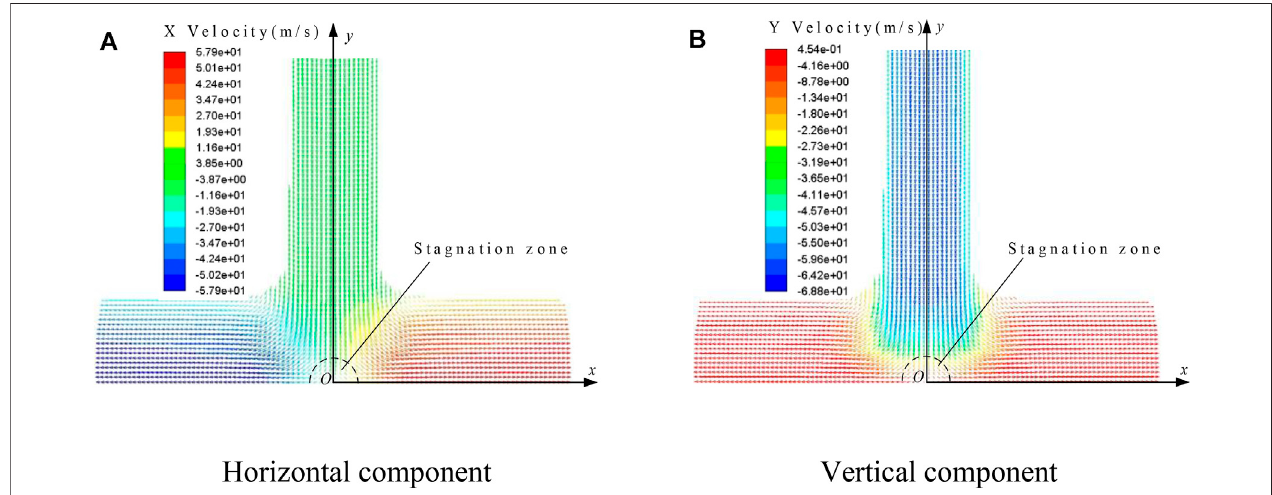
FIGURE 3 | The vector diagram of the water jet velocity fi eld without ultrasonic vibration ( P = 4 MPa). (A) Horizontal component, (B) Vertical component.